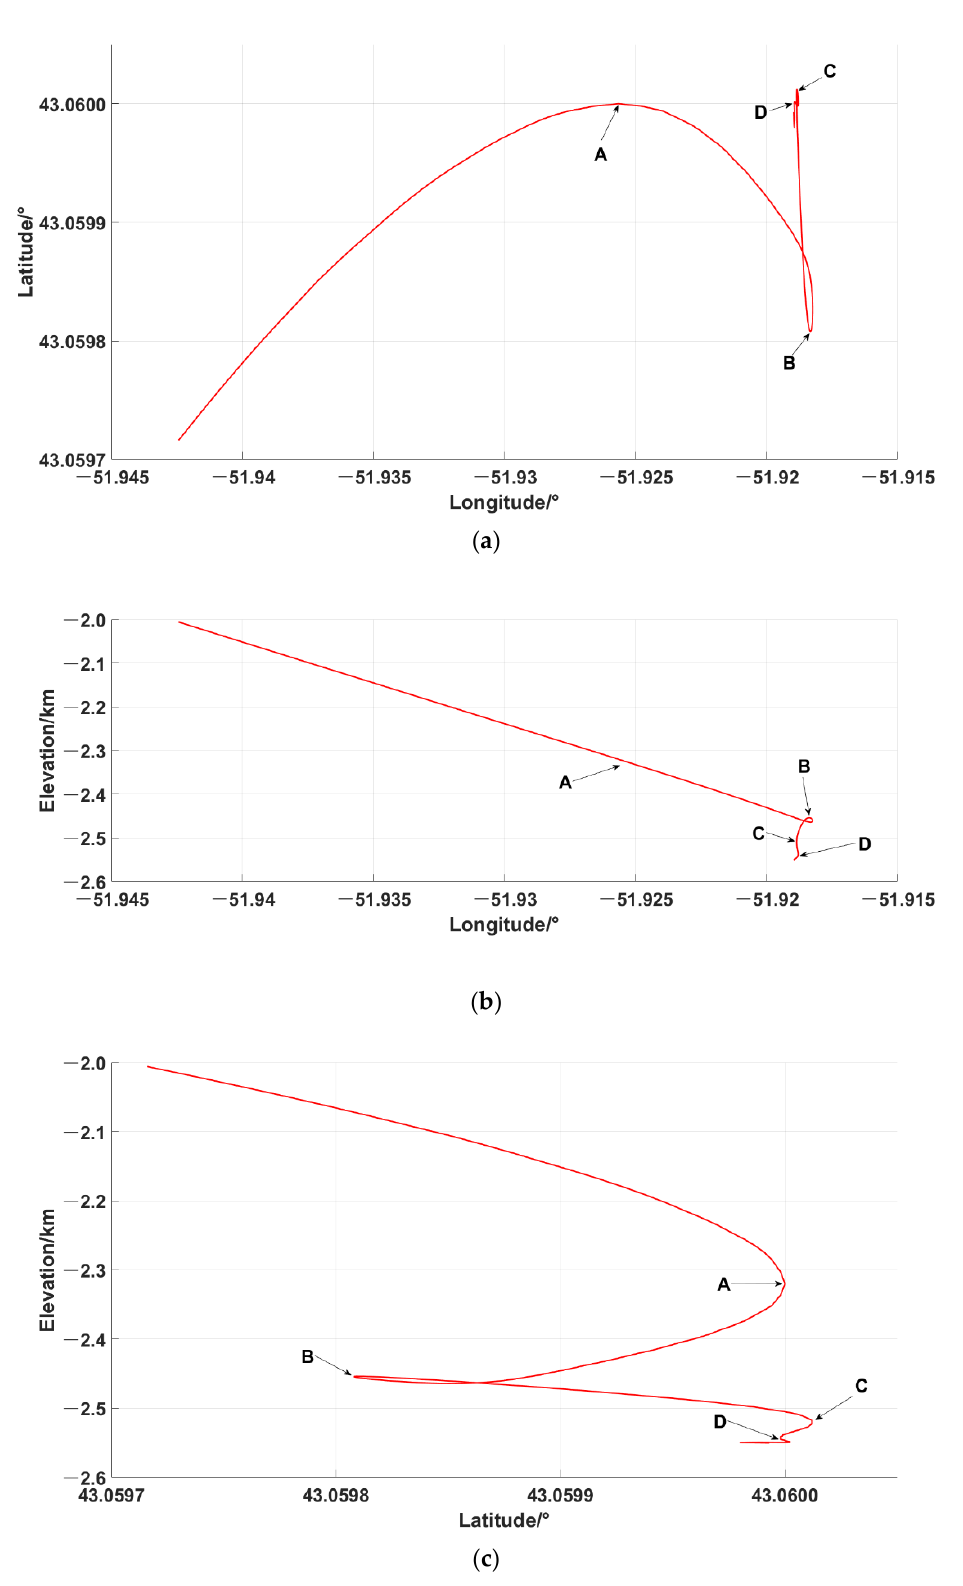
Figure 4. Descent trajectory of CE-5 is projected to three planes when elevation is under − 2 km: ( a ) shows the descent tra- jectory on latitude–longitude plane, ( b ) shows that on elevation–longitude plane; ( c ) shows that on elevation–latitude